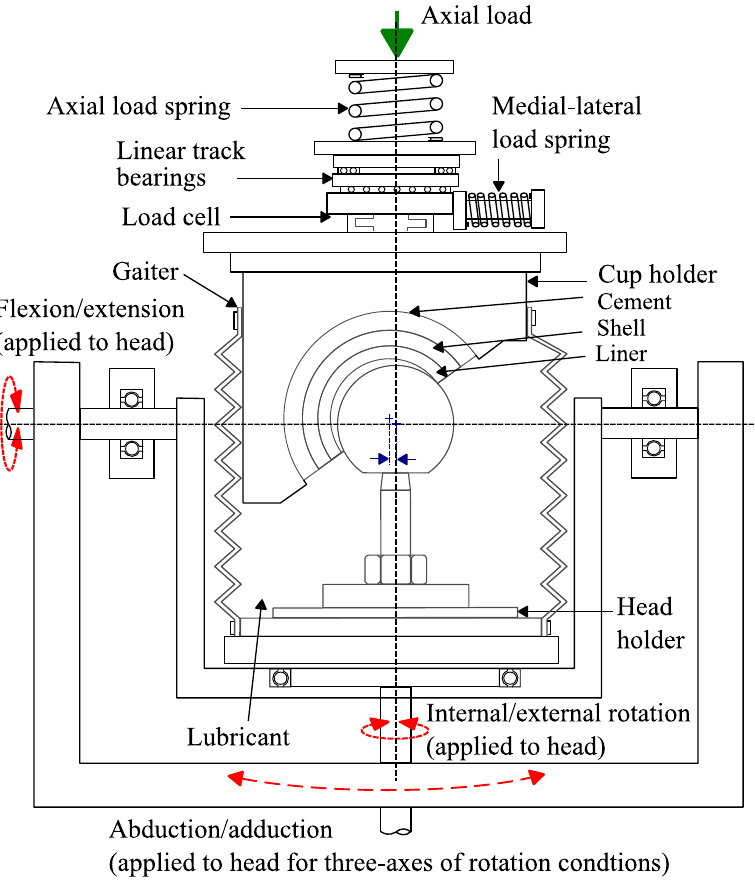
Figure 1. ProSim EM13 hip joint simulator with hip replacements under edge loading conditions.